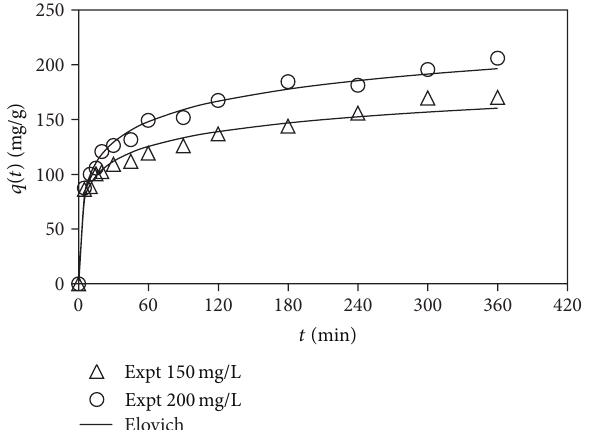
Figure 12: Intraparticle diffusion plots for sorption of glutaralde- hyde on